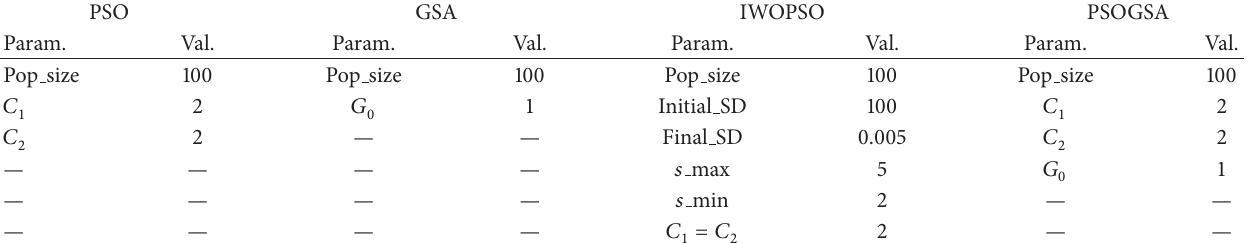
Table 2: Parameter setting for each algorithm.